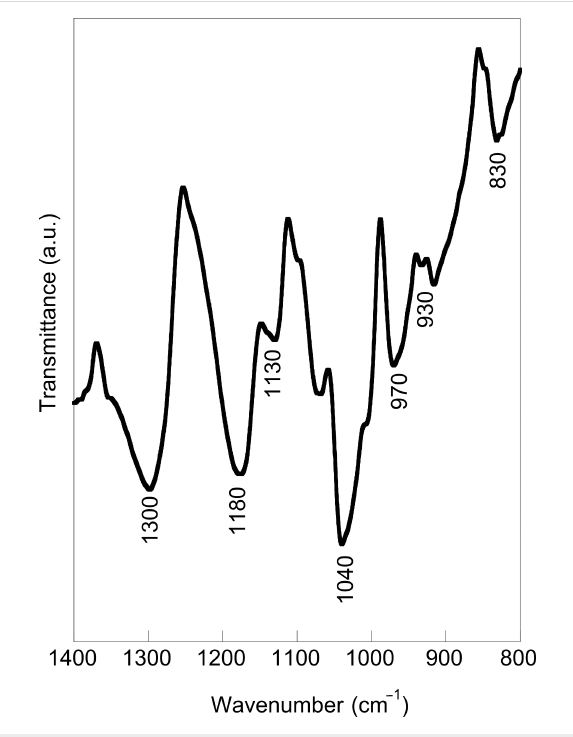
Figure 6: FTIR spectrum of a PEDOT film electropolymerized onto vitreous carbon.